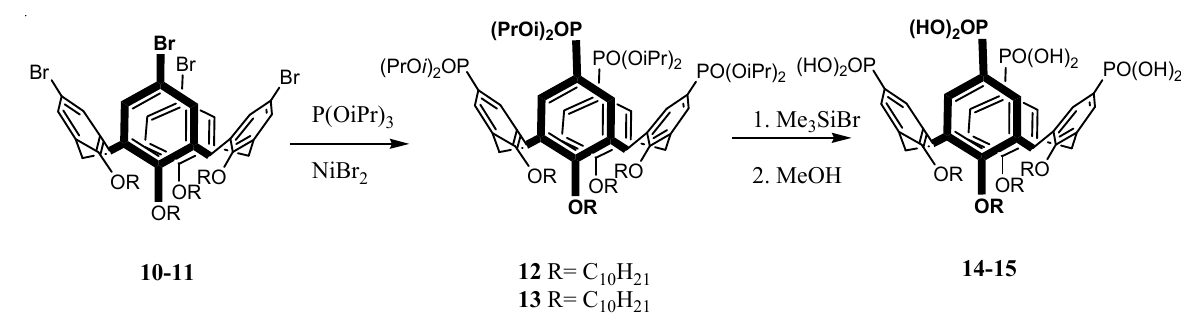
Figure 17. Synthetic route to the compounds 14 and 15